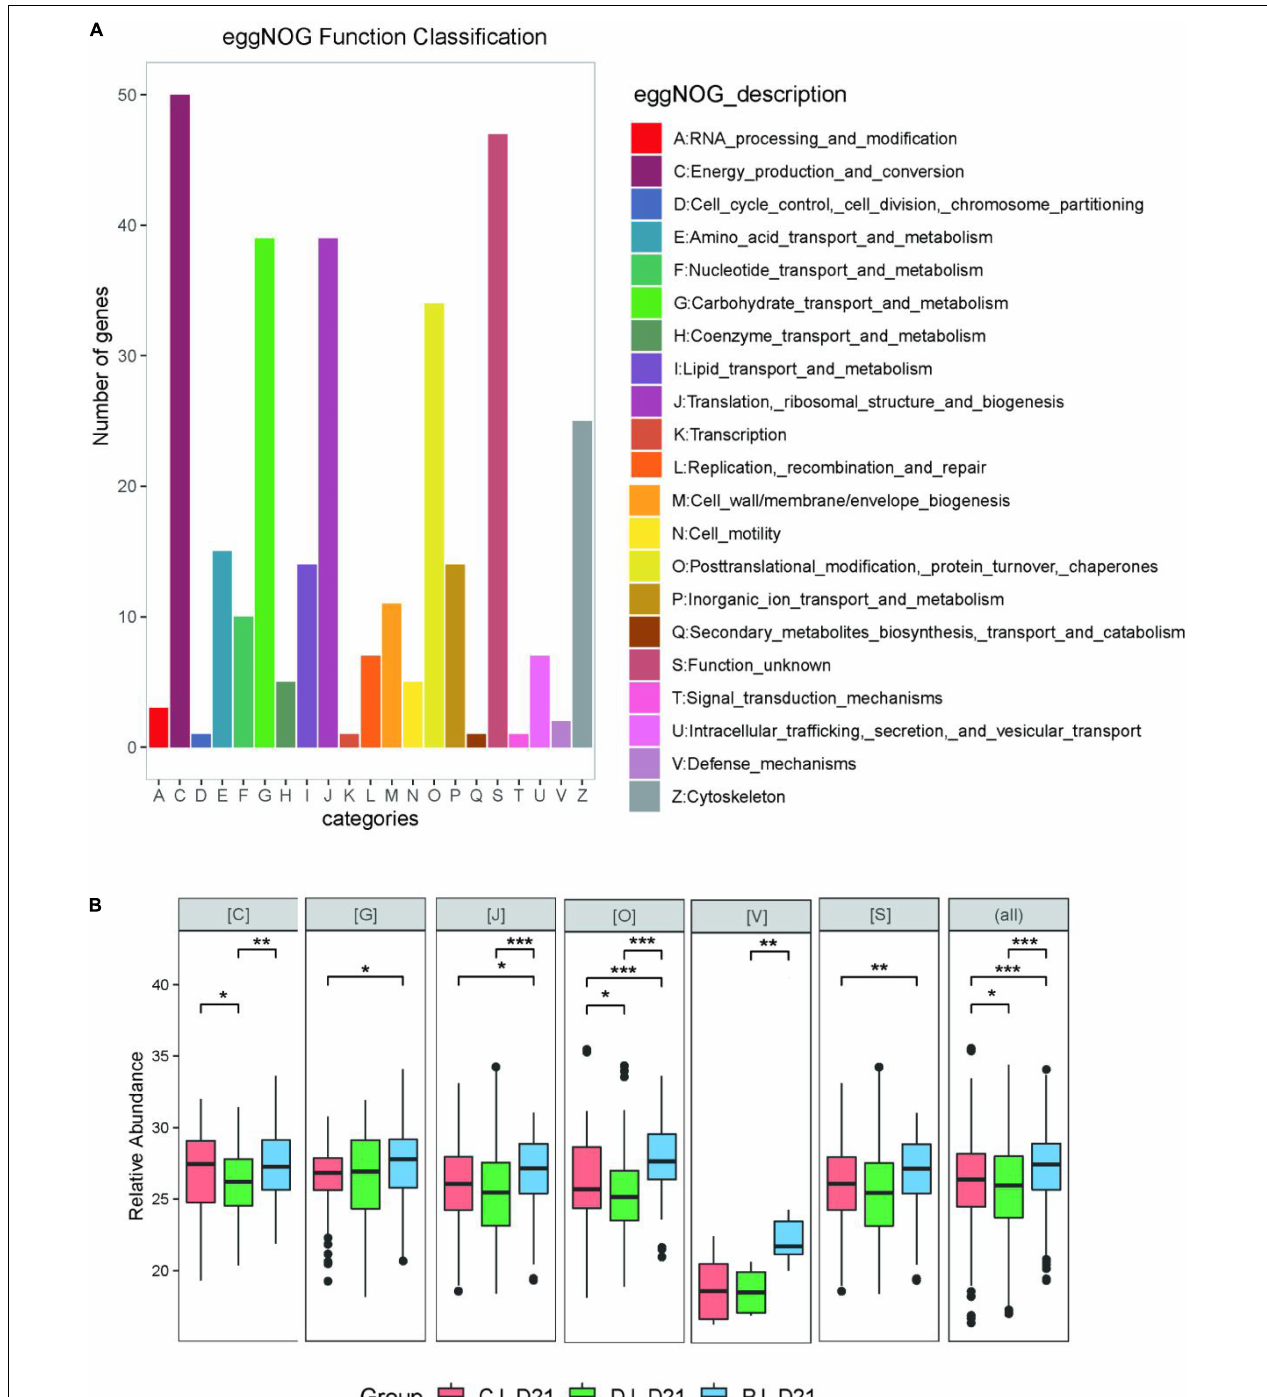
FIGURE 7 | (A) eggNOG classifications of the neonatal calves gut Metaproteomics. (B) LFQ intensity of COG category C (Energy production and conversion), category G (Carbohydrate transport and metabolism), category J (Translation, ribosomal structure and biogenesis), category O (Posttranslational modification, protein turnover, chaperones), and category V (Defense mechanisms) in microbiome of neonatal calves infected by E. coli K99. For the box plot, the bottom and top of the box represent the first and third quartiles, respectively. The middle line represents the sample median. Whiskers are drawn from the ends of the IQR to the furthest observations within 1.5 times the IQR range. Outliers > 1.5 times the IQR are indicated with circle. * p < 0.05, ** p < 0.01, *** p < 0.001.